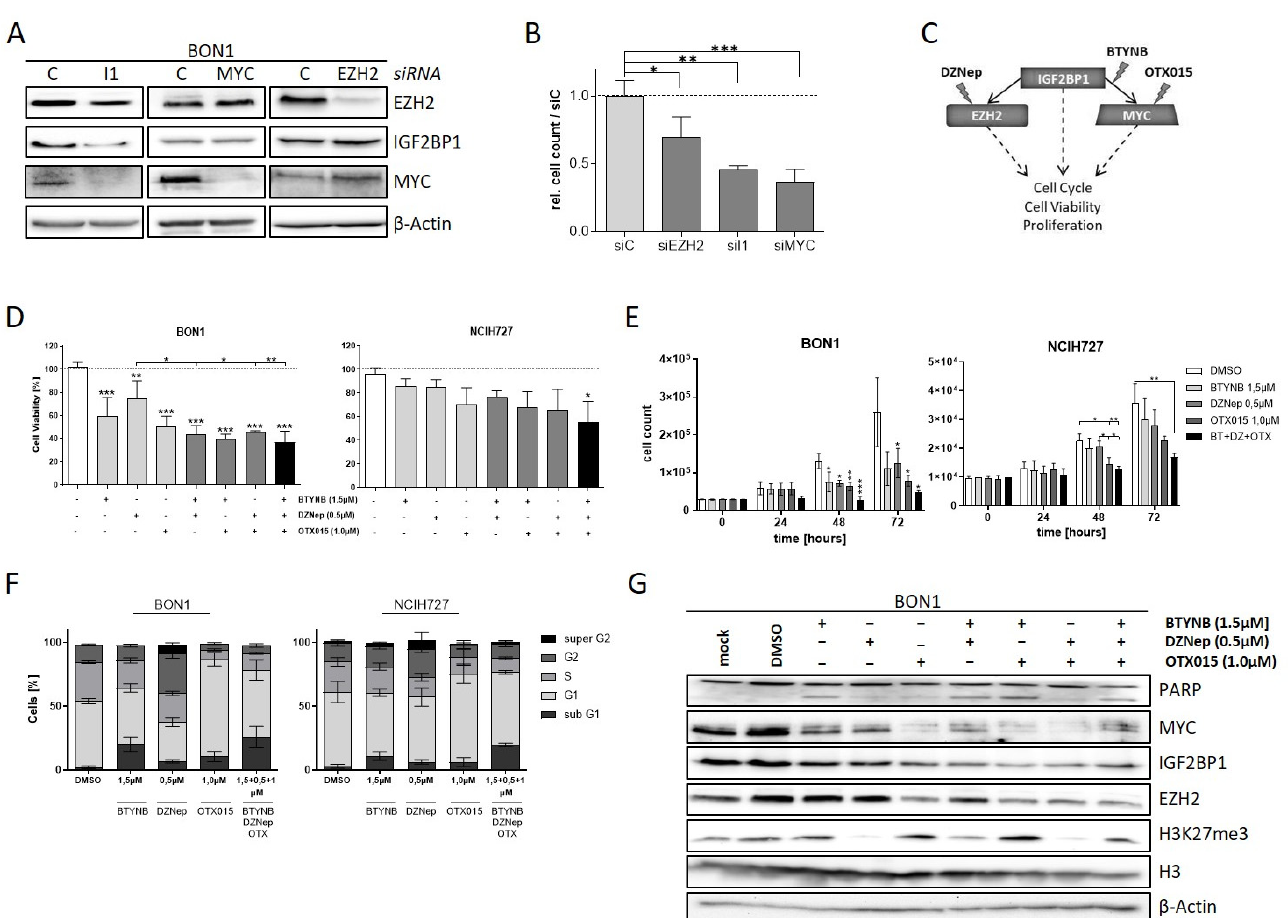
Figure 5. The IGF2BP1-MYC-EZH2 network is a target for pharmacological inhibition. ( A ) Representative Western blot of EZH2, IGF2BP1, and MYC knock-down in transfected BON1 cells. Actin served as loading control. ( B ) Proliferation of BON1 cells upon transfection with indicated siRNAs after 72 h. ( C ) Schematic strategy of IGF2BP1-MYC-EZH2 inhibition with commercially available inhibitors. DZNep targeting methylation activity of EZH2/PRC2 complex, BTYNB inhibiting IGF2BP1 binding to MYC mRNA and OTX015 inhibiting BRD2/3/4 transcription factors leading to reduced MYC expression. ( D ) Cell viability determined by Cell Titer Glo in BON1 and NCIH727 cells treated with indicated inhibitor concentrations for 72 h. Viability of DMSO treated cells served as control and was set to one. ( E ) Analysis of cell proliferation by cell counting at indicated time points upon treatment with indicated inhibitor concentrations. ( F ) Cell cycle analysis of NEN cells treated with indicated inhibitor concentrations for 72 h. Percentage of cells in indicated cell cycle phases were determined by propidium iodide staining. ( G ) Representative Western blot analysis of respective target proteins after treatment with indicated inhibitors for 72 h. Untreated (mock) and DMSO treated cells were used as expression controls. Actin served as loading control. Statistical significance was